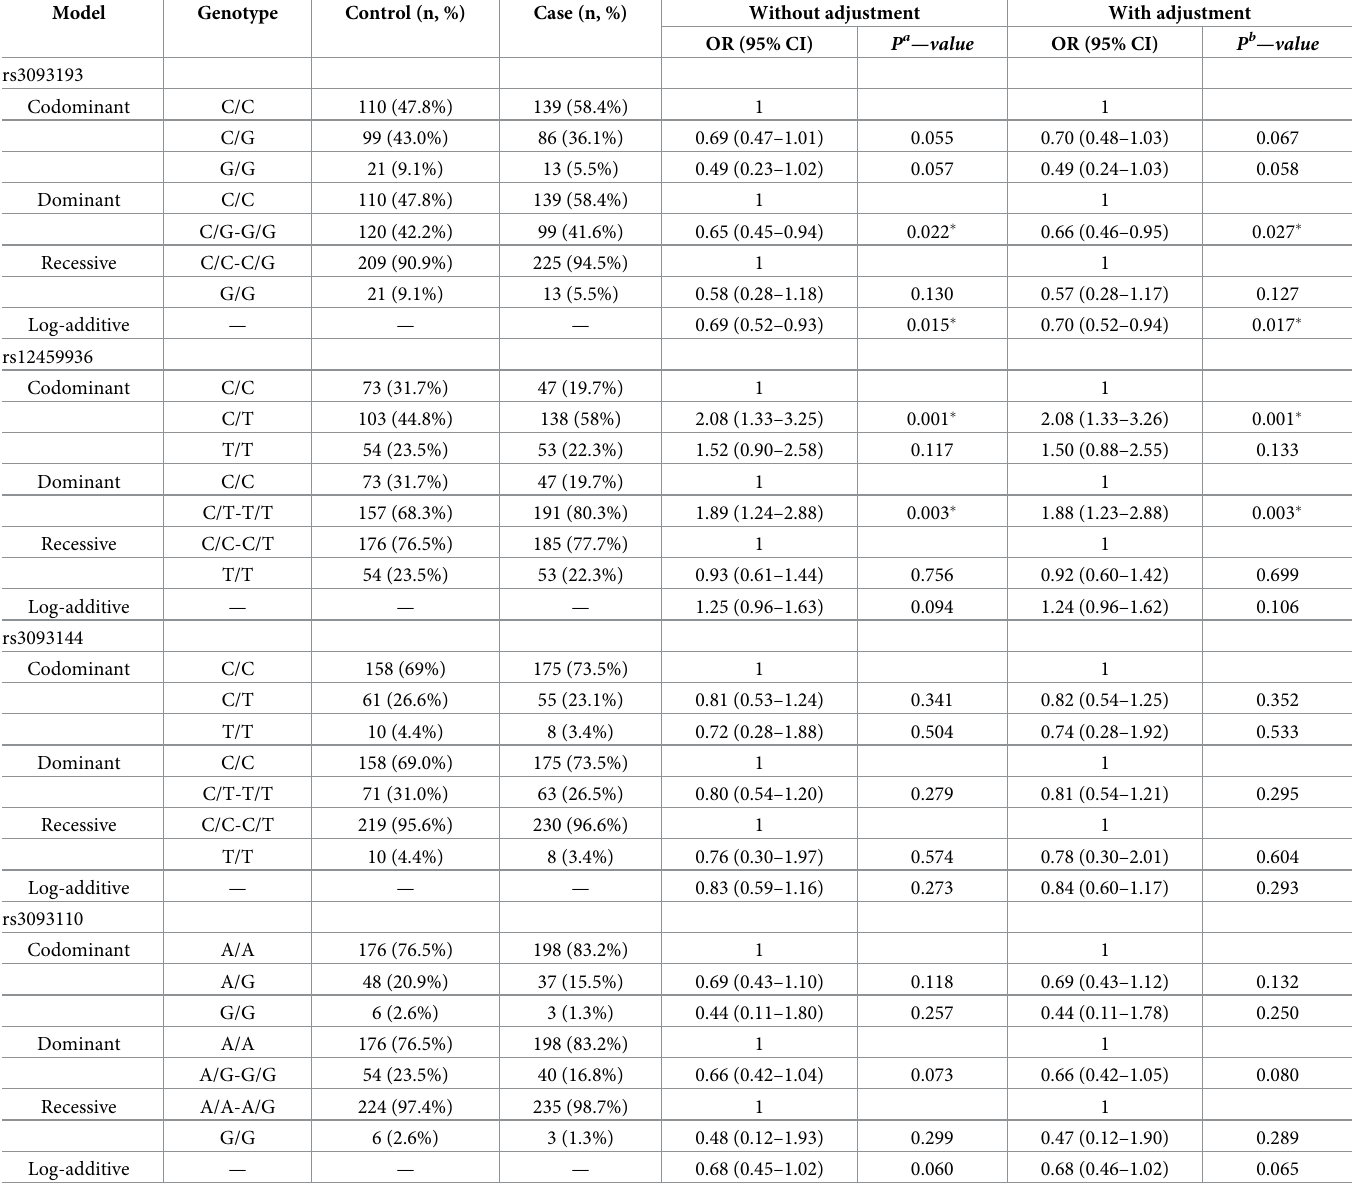
Table 5. Logistic regression analysis of the association between the SNPs in CYP4F2 gene and HAPE risk.